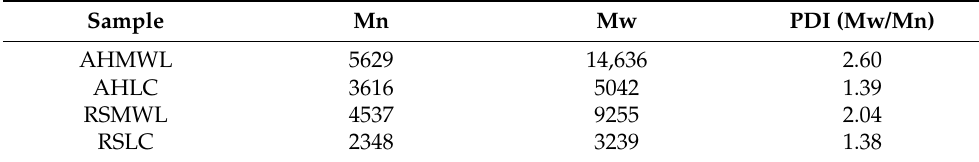
Table 5. Molecular weight of AHMWL, AHLC, RSMWL, and RSLC.